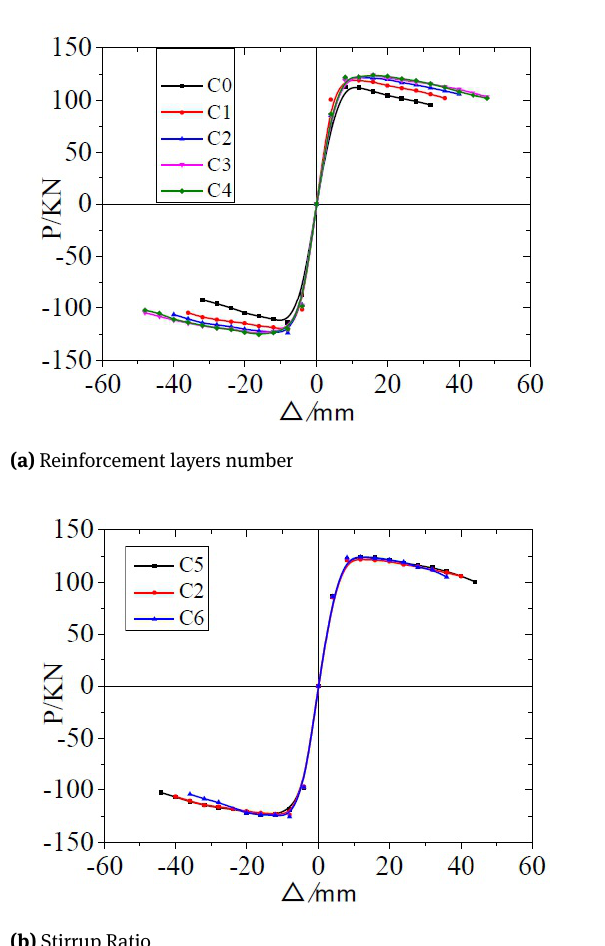
Figure 20: The contrast skeleton curves